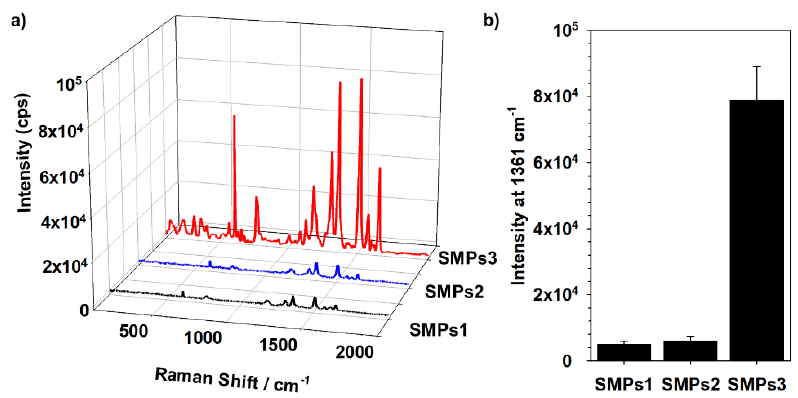
Figure 3. SERS analysis of each SMPs after 10 − 5 M of R6G treatment under 633 nm laser irradiation: ( a ) representative Raman spectra of each SMPs and ( b ) Raman intensity of each SMPs at 1361 cm − 1 . ( λ = 633 nm, laser power: 5 mW).